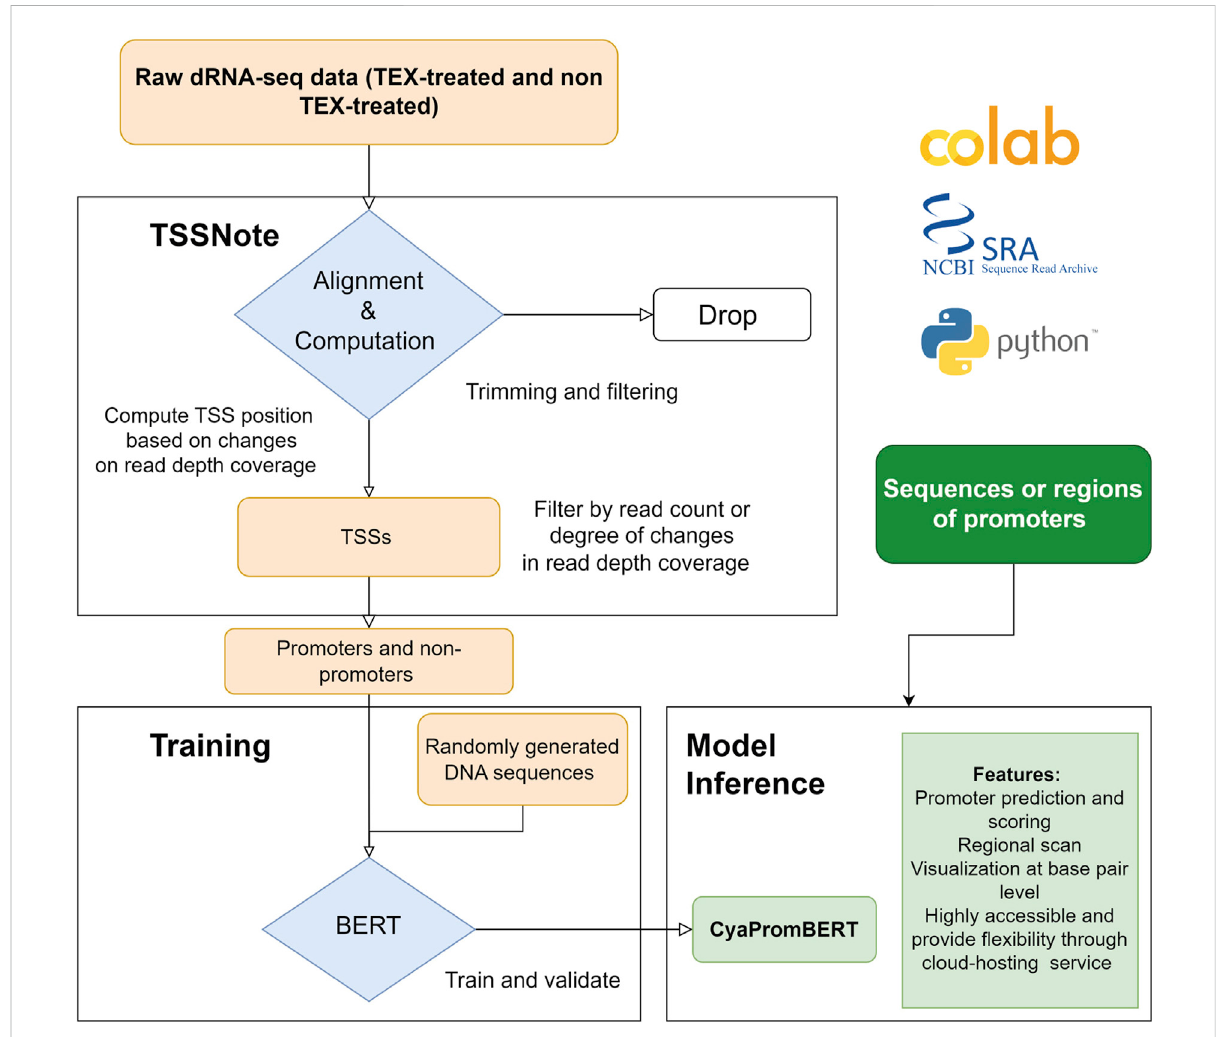
FIGURE 1 Overall scheme for constructing and developing TSSNote and CyaPromBERT. TSSNote facilitates downloading raw dRNA-seq datasets from NCBI SRA database and conducts alignment, sorting, and fi ltering for extracting promoters and non-promoters. These sequences are later used to train a BERT model for the task of promoter prediction. Randomly generated DNA sequences with similar size to promoter length are added to reduce biases, and over fi tting is used to improve the model ’ s robustness. The trained model is capable of promoter prediction, regional scanning, and visualization at base-pair